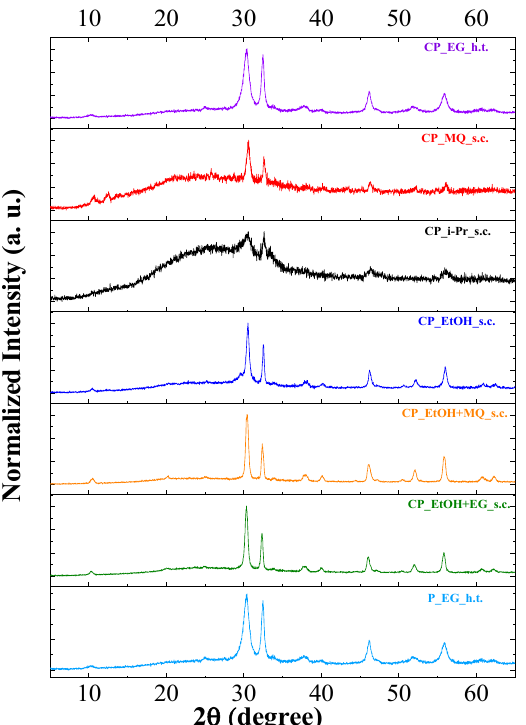
Figure 1. X-ray di ff raction pattern of the BiOI layer on the ceramic paper: the e ff ect of the solvent Figure 1. X-ray diffraction pattern of the BiOI layer on the ceramic paper: the effect of the solvent or the solvent mixture on the crystallographic properties and the two main peak ratios ( I (102) /I (110) ).